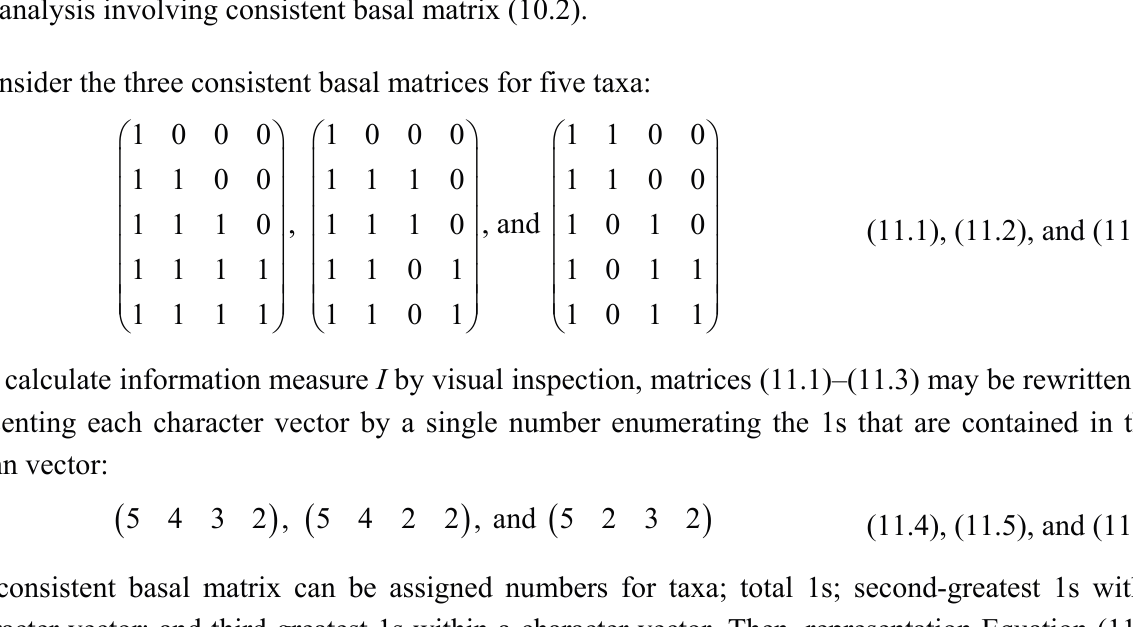
Figure 2. Cladogram topologies for the two possible consistent basal matrices for four taxa: the pectinate cladogram at the left would be obtained from a cladistic analysis involving consistent basal matrix (10.1); the symmetric cladogram would be obtained from a cladistic analysis involving consistent basal matrix